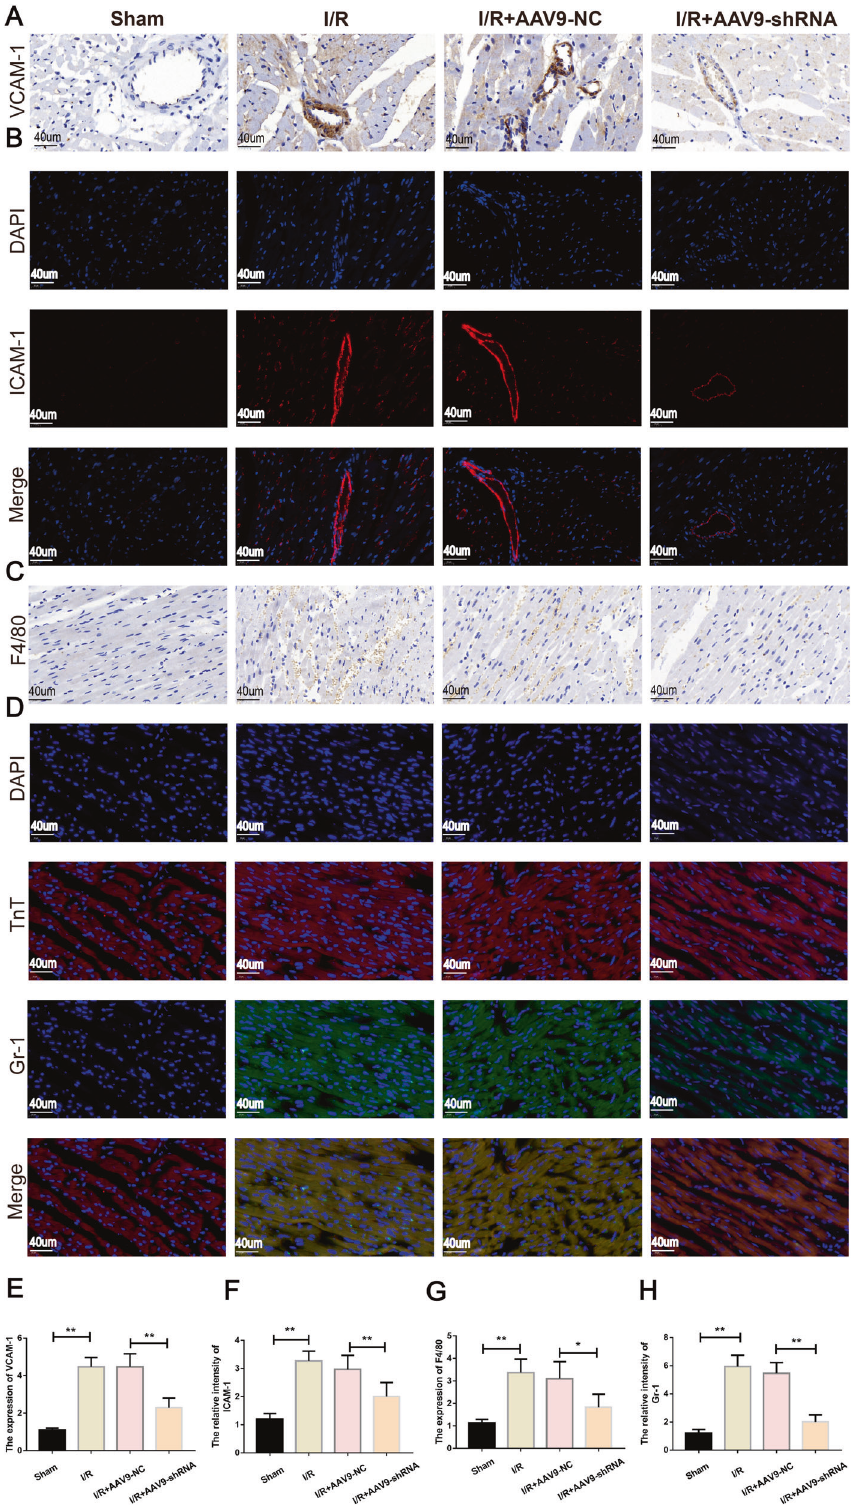
Fig. 5 mmu_circ_0000021 suppression inhibited leukocyte in fi ltration in the myocardium following I/R. A , E Immunohistochemistry was used to analyze the microvasculature for VCAM-1 expression. B , F Immuno fl uorescence assays were used to assess ICAM-1 expression in the microvasculature. C , G Immunohistochemistry revealed the presence of neutrophils stained with F4/80. D , H Gr-1 was used to stain the neutrophils, while cTnT was used to stain the myocardium. Colocalization of Gr-1 and cTnT in the heart indicates that neutrophils have migrated into the myocardium. * P < 0.05, ** P < 0.01. vs. indicated group, n = 8/group.